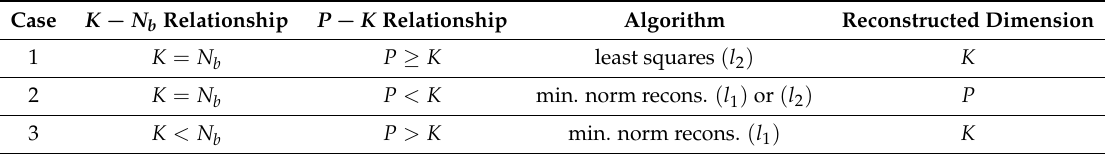
Algorithm Reconstructed